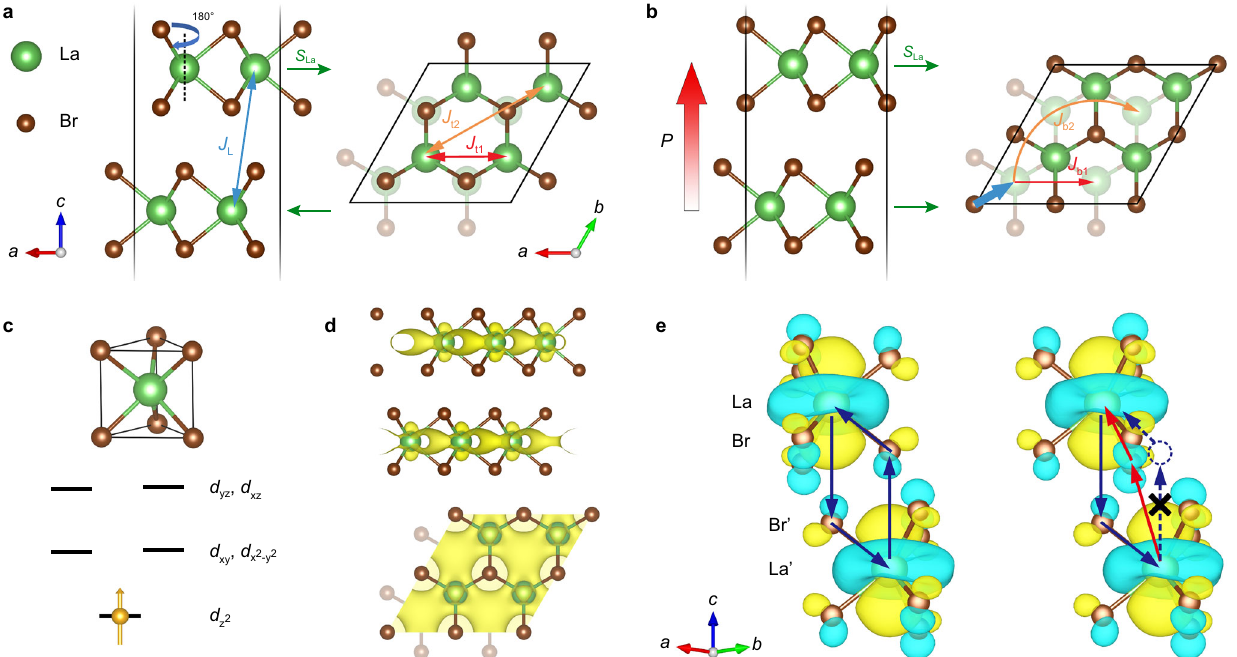
Fig. 1 The lattice structure of bilayer LaBr 2 . a , b show both the side and top views of 2 H - and 3 R -type stacking, respectively. S La represents the spin direction of La ions in upper and lower layer. c The splitting of 5 d orbitals for La 2 + in the trigonal prismatic crystal fi eld. d Spin density for 3 R LaBr 2 bilayer. e The maximally localized Wannier of La-5 d z2 states for 2 H and 3 R type. Yellow and cyan colors represent positive and negative, respectively, isovalue surfaces of the Wannier function. The red and blue arrows represent FM and AFM superexchange paths between different atoms,